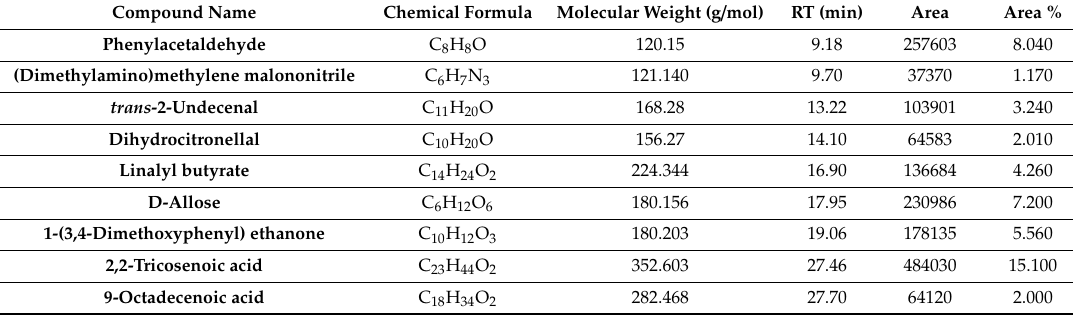
Table 3. Compounds identified in the ethyl acetate fraction of R. stricta using